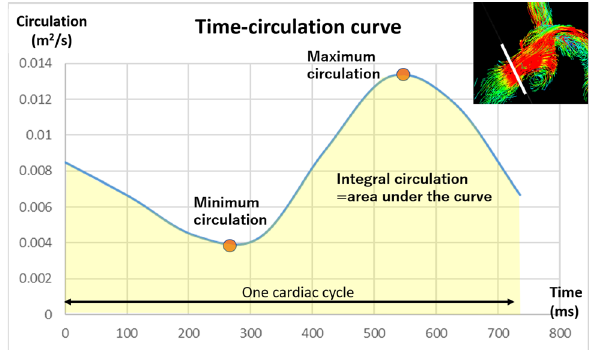
Figure 3. Time-circulation curve of the cross section of the proximal main pulmonary artery (white line in the right upper figure). The maximum and minimum values were obtained from the time- circulation curve. The integral value (area under the time-circulation curve = yellow area) was obtained by integration of the circulation values throughout a single cardiac